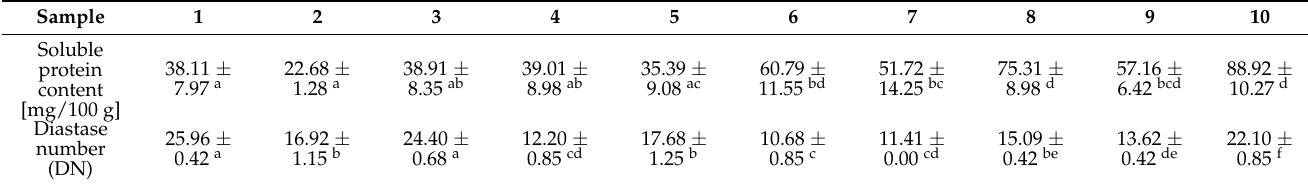
Table 1. Protein content and diastase number (DN) of tested honey samples.